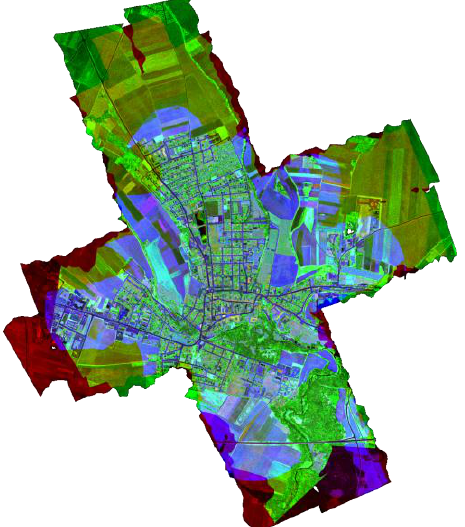
Figure 7. Active multi-wavelength reflectance image estimated from radiometrically calibrated ALS data sets; 532nm (linear scale from 0 (black) to 0.15 (blue)); 1064nm (linear scale from 0 (black) to 1 (green)) and 1550nm (linear scale from 0 (black) to 1 (red)).